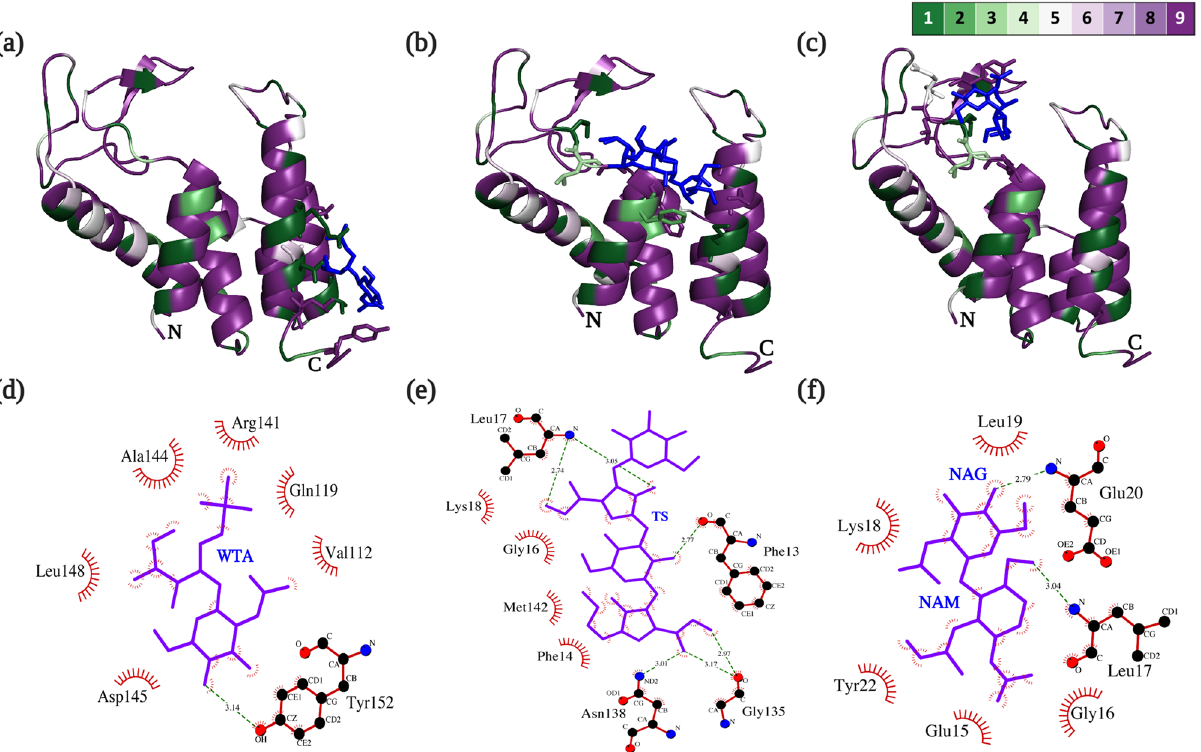
Figure 4. Protein–ligand docked complexes: the 3D structure of CL1-C600M2-lysin is represented using ConSurf 42,43 output complexed with ligands ( a ) WTA; ( b ) TS and ( c ) PG. Interacting residues are denoted as sticks and colored based on the represented conservation scale with dark purple being highly conserved and dark green being highly variable. N and C terminal of each structure is indicated by N and C, respectively. All ligands are represented in dark blue irrespective of their kind. Ligplot maps for interacting residues for protein ligand complexes, ( d ) CL1-C600M2-lysin–WTA, ( e ) CL1-C600M2-lysin–TS and ( f ) CL1-C600M2-lysin–PG. The sugar components of PG, β-(1,4) linked N -acetylglucosamine (NAG) and N -acetylmuramic acid (NAM) are labelled.